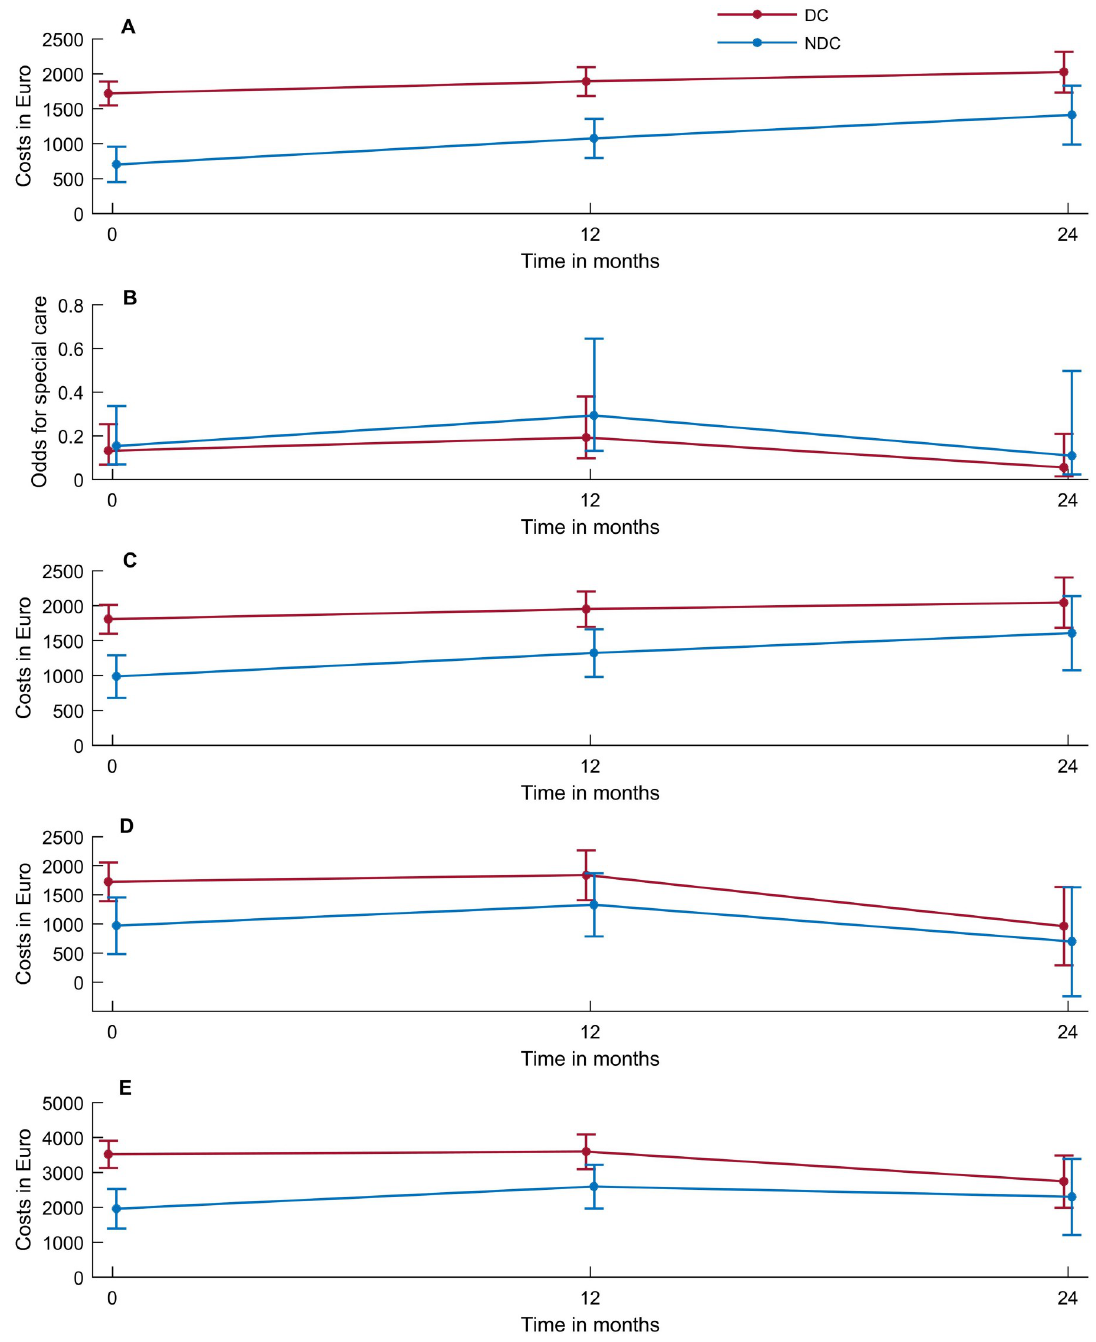
Fig 1. Time trends for the DC group and NDC group at BL, FU1 and FU2. A : Cost for primary care; B : Odds for secondary care; C : Cost for formal care; D : Costs for informal care; E : Total costs . BL = baseline; FU1 = follow-up1 at 12 months; FU2 = follow-up2 at 24 months; DC = users of day care centres designed for dementia; NDC = non-users of day care centres designed for dementia.